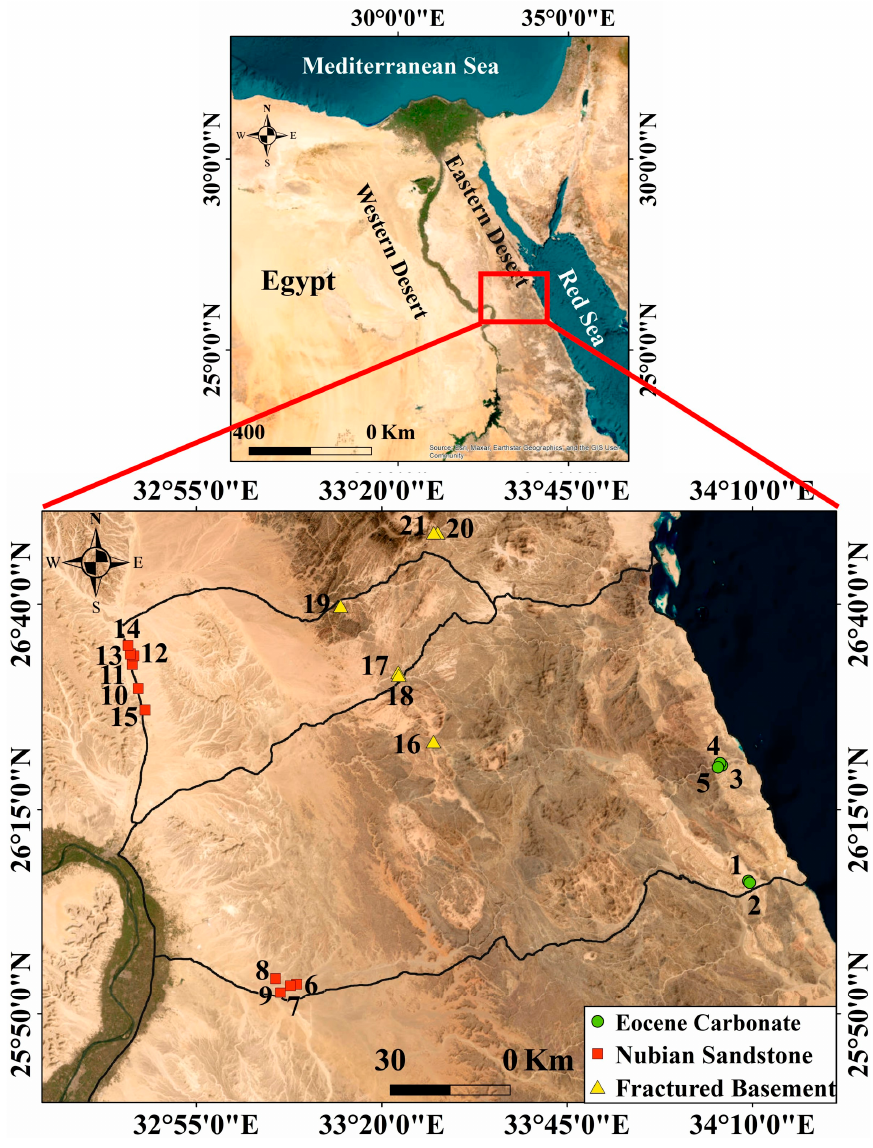
Figure 1. The study area and sampling site’s